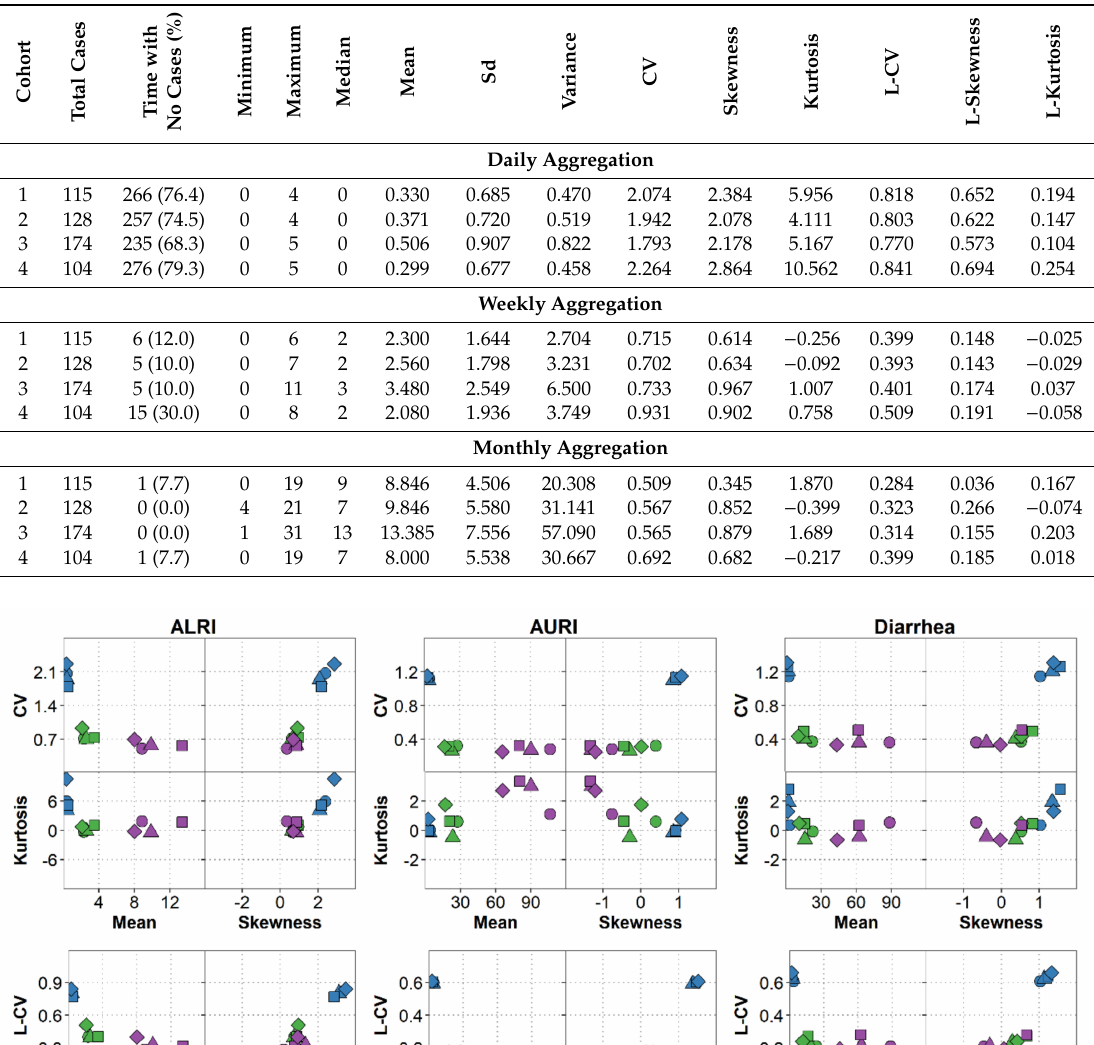
Table 5. Descriptive statistics for daily, weekly, and monthly time series of ALRI.